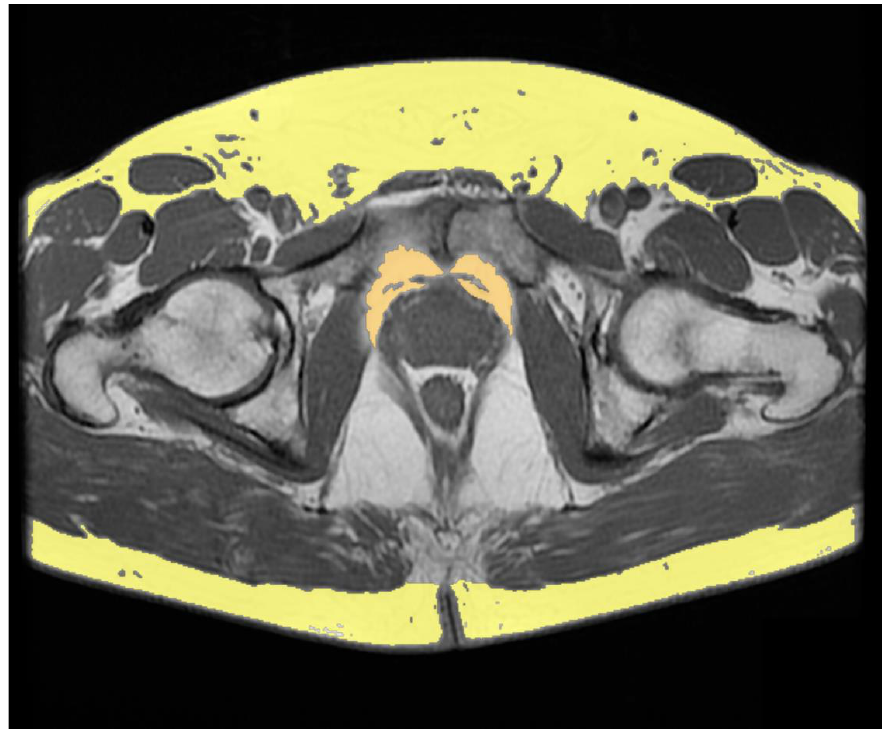
Figure 2. Axial T1-weighted MRI image showing periprostatic adipose tissue segmented in orange and SAT segmented in yellow.